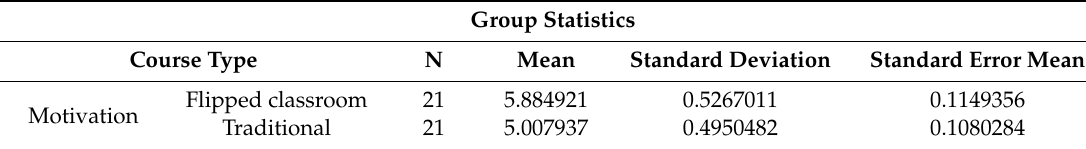
Table 3. Descriptive statistics for student motivation.